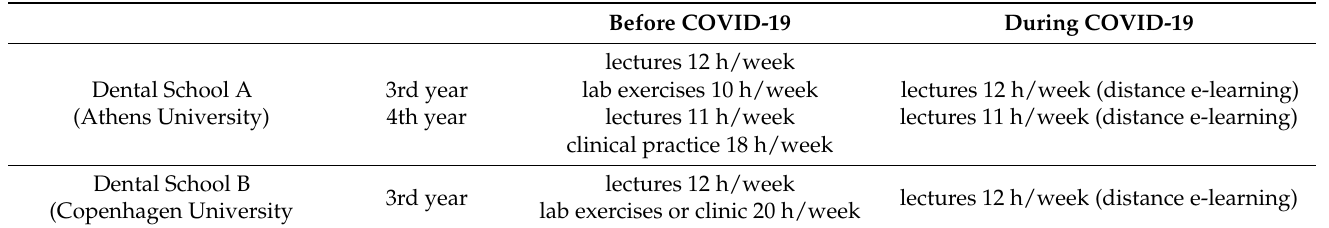
Table 1. The teaching structure of all the courses in the third- and fourth-year curriculum for the two Dental Schools, before and during the COVID-19 pandemic era. Before COVID-19 During